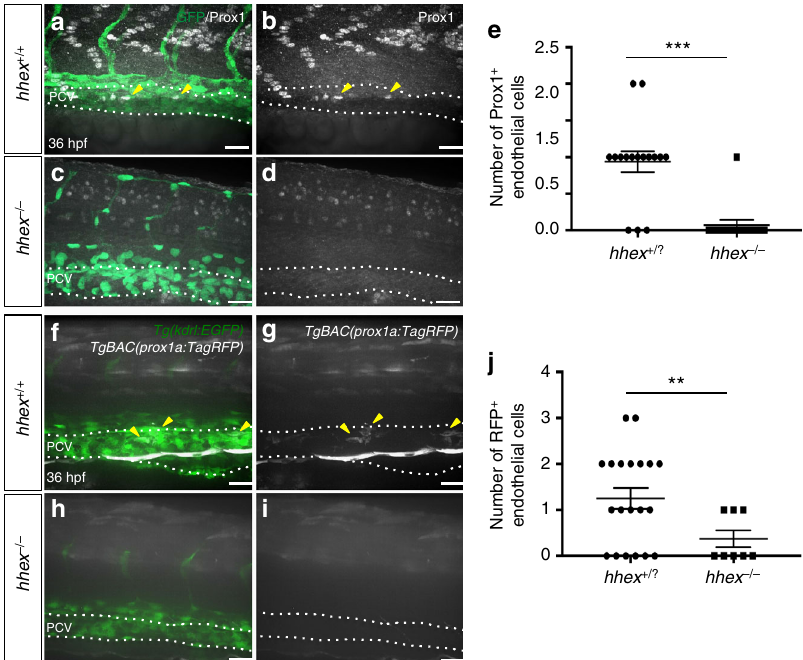
Fig. 3 Zebra fi sh hhex mutants lack lymphatic precursors. a – d Whole-mount views of 36 hpf hhex + / + and hhex − / − embryos immunostained for Prox1 (arrowheads point to Prox1 + endothelial cells in the PCV). e Quanti fi cation of the number of Prox1 + endothelial cells across three somites (from two fi eld of view per embryo) in hhex + /? ( n = 8) and hhex − / − ( n = 6). f – i Whole-mount views of 36 hpf Tg(prox1a:TagRFP); hhex + / + and hhex − / − embryos. hhex mutants exhibit a strong decrease in the number of RFP + cells in the PCV compared to hhex + / + (arrowheads point to RFP + endothelial cells in the PCV). j Quanti fi cation of the number of RFP + endothelial cells across three somites (from two fi eld of view per embryo) in hhex + /? ( n = 10) and hhex − / − ( n = 4). Values represent means± s.e.m. *** P ≤ 0.001, and ** P ≤ 0.01 by t -test. Scale bars: 50 μ